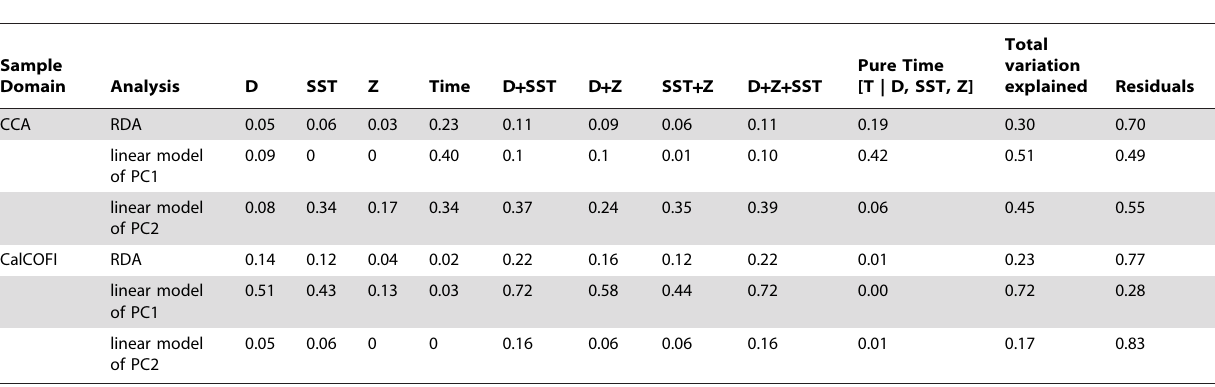
Table 3. Adjusted R 2 values from partitioning of the amount of variation explained by depth (D), sea surface temperature (SST), zooplankton volume (Z) and year of sampling (time) for interannual analysis of assemblage structure at the CCA and CalCOFI scales.